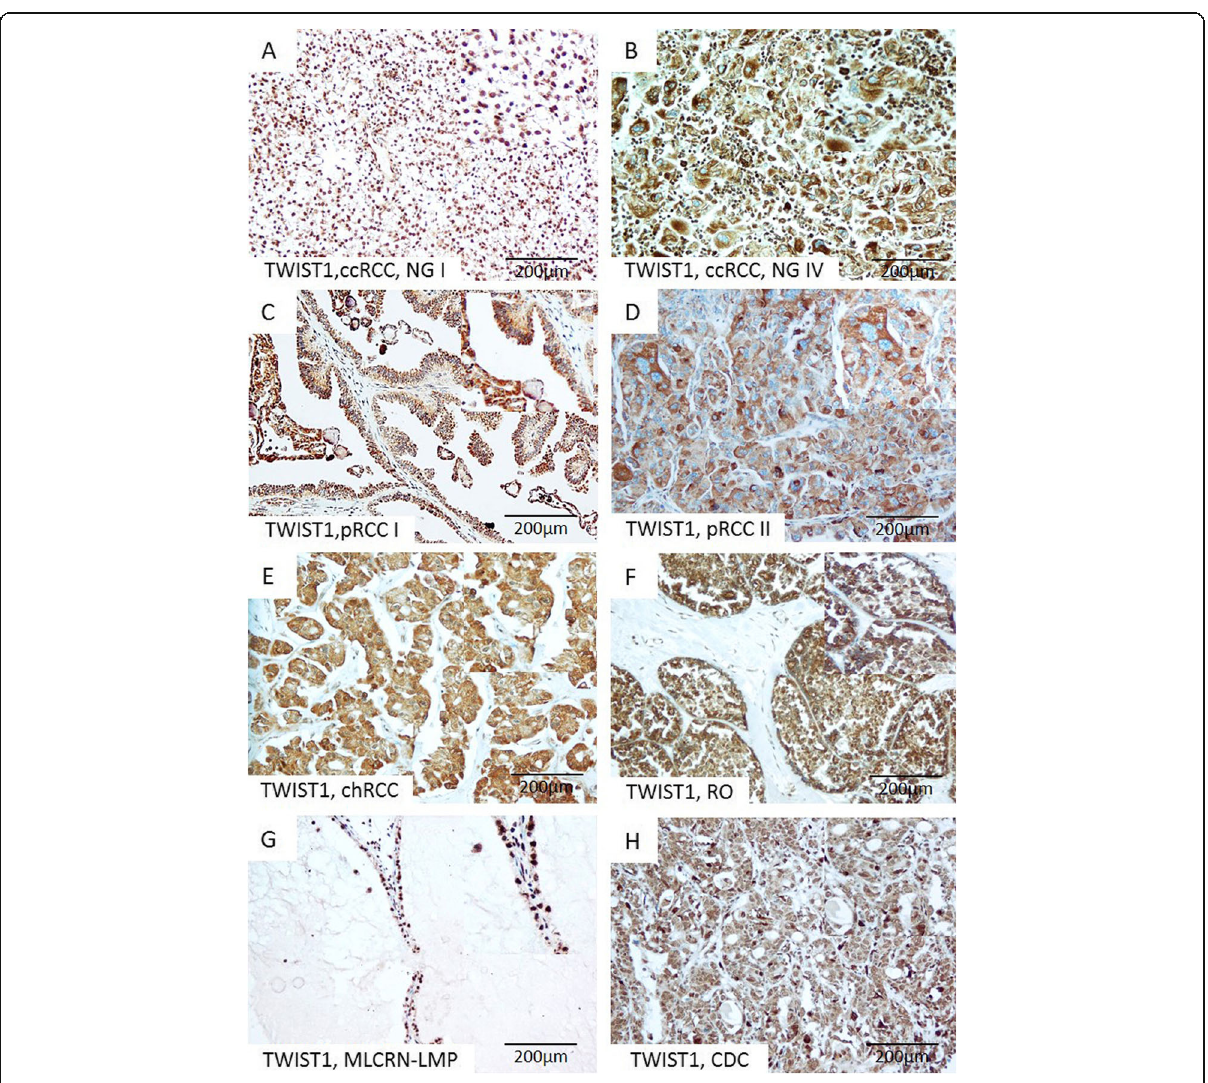
Fig. 3 Representative microscopic photographs of TWIST1 expression in various RCT. ( a ) Strong diffuse nuclear expression in low-grade ccRCC, ( b ) Cytoplasmic immunopositivity in high-grade ccRCC, ( c – f ) Cytoplasmic immunopositivity in pRCC, type I, pRCC, type II, chRCC and RO, respectively, ( g – h ) Nuclear expression in MLCRN-LMP and CDC, respectively. Original magnification, × 200. Abbreviation: NG-nuclear